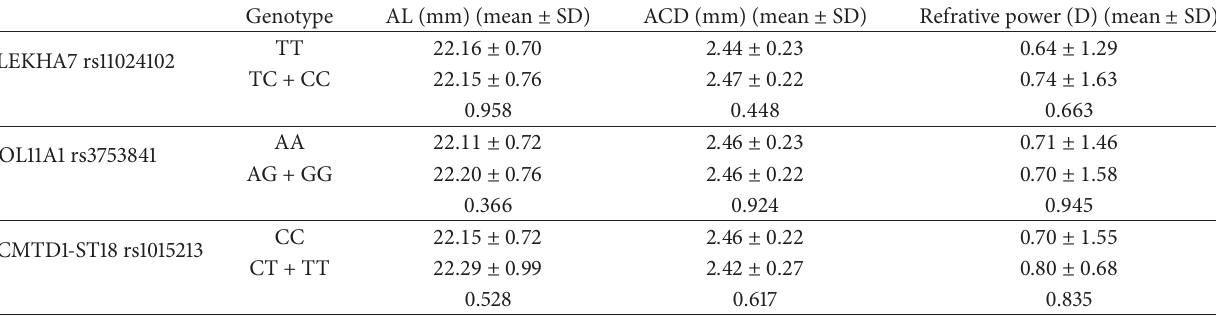
Table 5: The relationship of biometric parameters with genotypes of rs1015213, rs375384, and rs11024102 in PAC